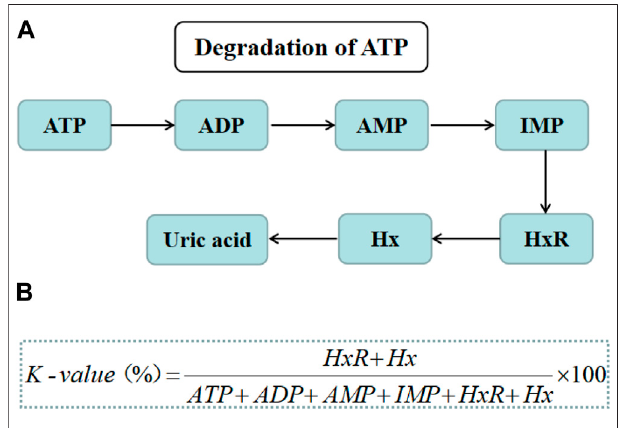
FIGURE2|(A) TheATPdegradationprocess. (B) Theformulasusedfor calculating K